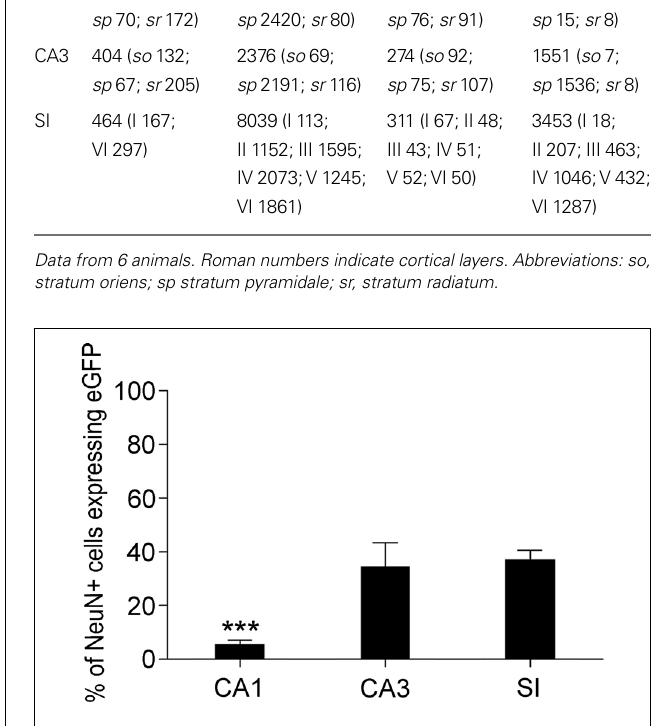
FIGURE 3 | Percentage of NeuN/eGFP co-localization varies across different cortical regions. NeuN/eGFP + double-labelled cells are signifi cantly more numerous in CA3 and SI than in CA1. Values are mean ± sem. Data collapsed from all layers of each region from six animals. *** P < 0.001.